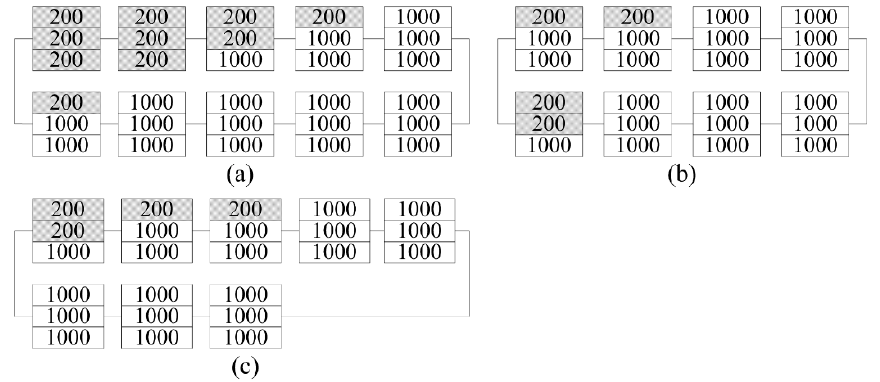
Figure 15. ( a ) Primary configuration C ori ; ( b ) optimized configuration C EMPP ; and ( c ) optimized configuration C opt .